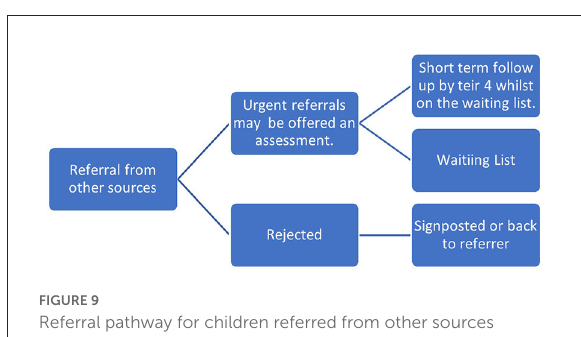
FIGURE9 Referral pathway for children referred from other sources (Site